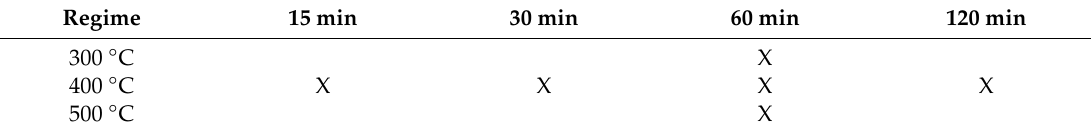
Table 2. Times and temperatures of tempering. “X” marks regimes of tempering in corresponding fields.